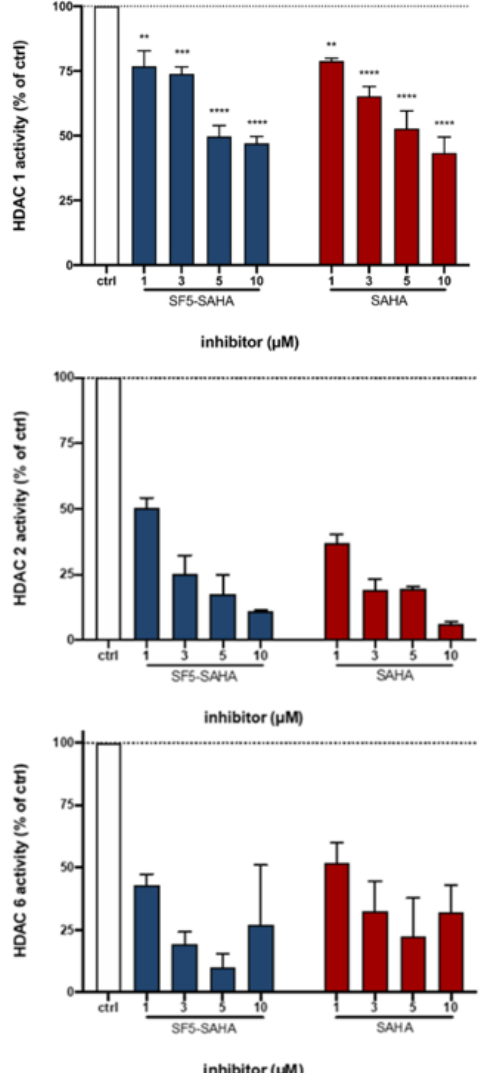
Figure 7. Inhibition of HDAC1 (top), HDAC2 (middle) and HDAC6 (bottom) by SF5-SAHA and SAHA. HDAC activity was measured by luminescence display of the acetylation state of histones. Human recombinant HDAC1, HDAC2 and HDAC6 enzymes and adjacent fluorgenic HDAC sub- strates were used to determine subtype specific HDAC activity levels after preincubation with SF5-SAHA and SAHA. Results are given as relatives to controls, not preincubated with inhibitor, as means ± SEM of n = 3 independent experiments. ** p ≤ 0.005, *** p ≤ 0.0005, **** p ≤ 0.0001; 2-way ANOVA Dunnett ’ s post-hoc test.